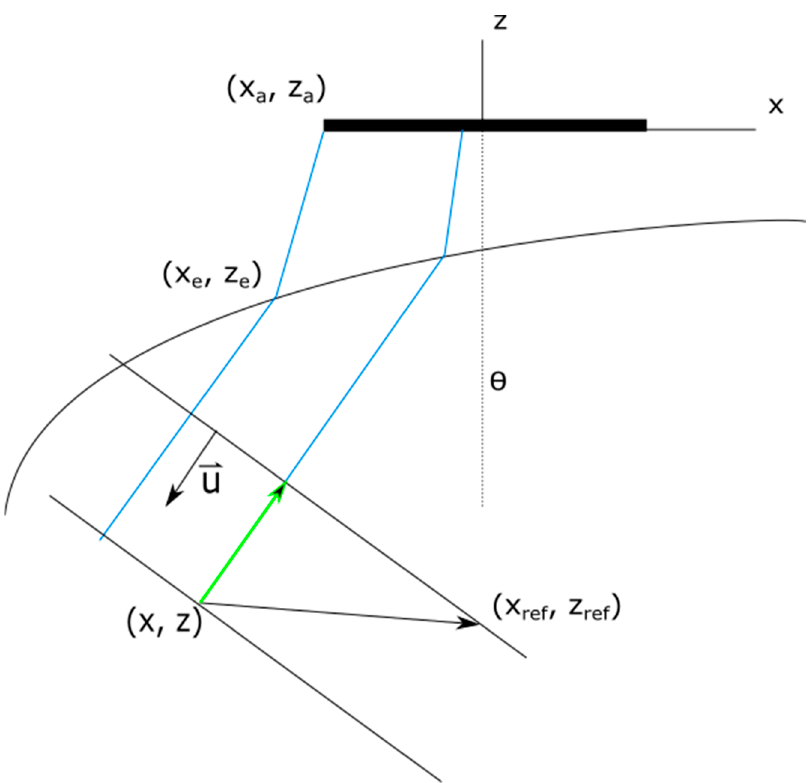
10 of 17 4. Image Formation Algorithm 4.1. Time-of-Flight Calculation After each plane wave emission, the signals received by all the array elements are